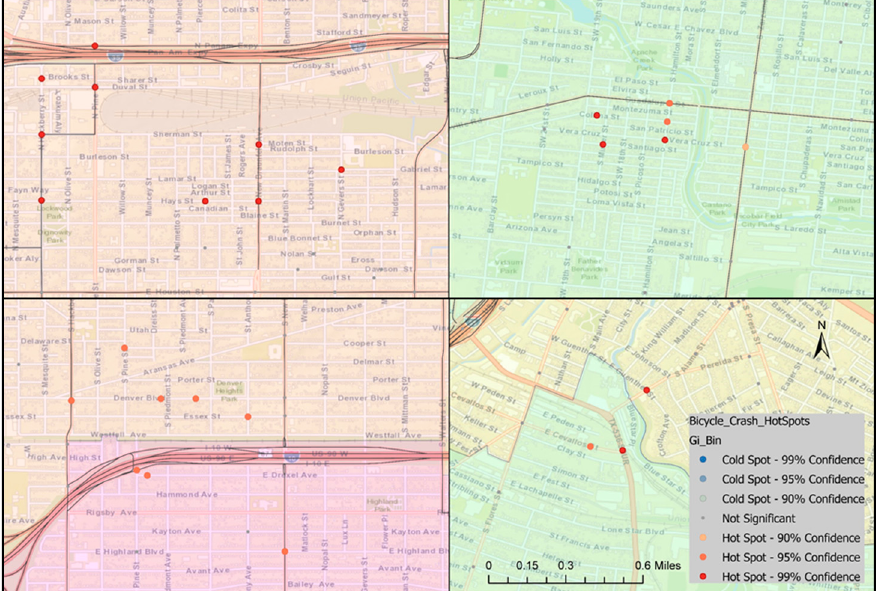
Figure 4. Locations with statistically significant cluster of bicycle crashes near the intersections at N New Braunfels Ave and Hays St ( top left ), Guadalupe St and S Hamilton St ( top right ), S Hackberry St and Denver Blvd ( bottom left ), and E Cevallos St and TX-536 SPUR ( bottom right